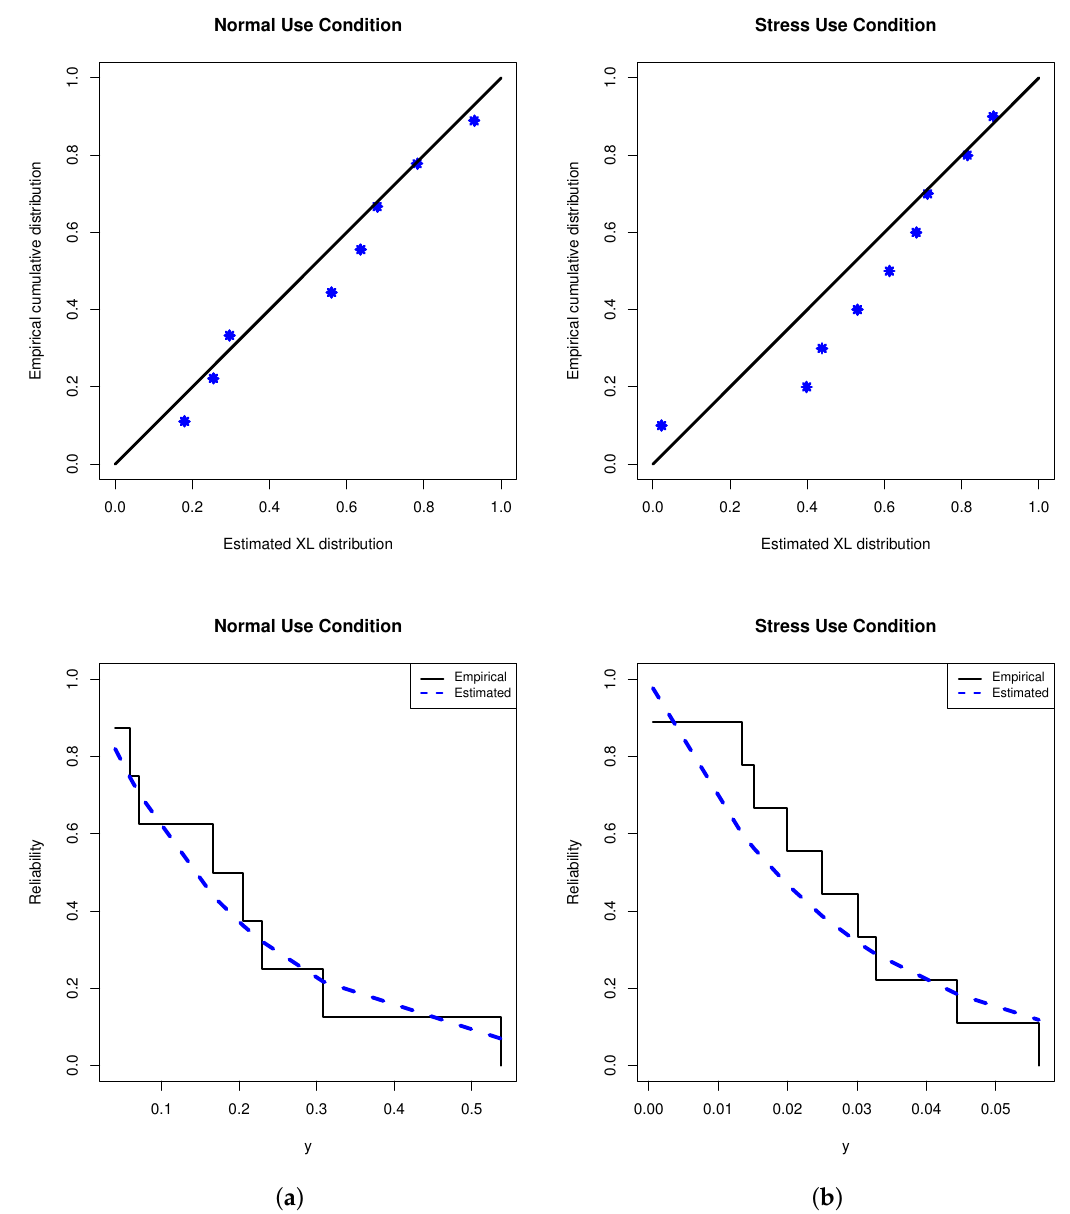
Figure 9. Fitted RF ( right ) and PP ( left ) plots from TLT data. ( a ) Normal condition; ( b ) stress condition. From Table 4, based on several choices of m j = 5, i = 1, 2 and ( R j 1 , R j 2 , . . . , R jm artificial constant stress PT-IIC samples are generated and provided in Table 5. For each sample, in Table 6, the Bayes and maximum likelihood estimates along with their SEs as well as the 95% ACI/BCI estimates along with their lengths of λ , β , α u , G u ( t ) and H u ( t ) (at t = 1 and x u = 20) are calculated and provided. Just like our assumption about the prior parameters in Section 6.1, the acquired Bayes point/interval analyses are made. It is seen that the calculated point and interval estimates of λ , β , α u , G u ( t ) and H u ( t ) , derived from the Bayes MCMC and likelihood estimation methods, are quite similar to each other. simulated Markovian chains of λ , β , α u , G u ( t ) or H u ( t ) , for each generated sample